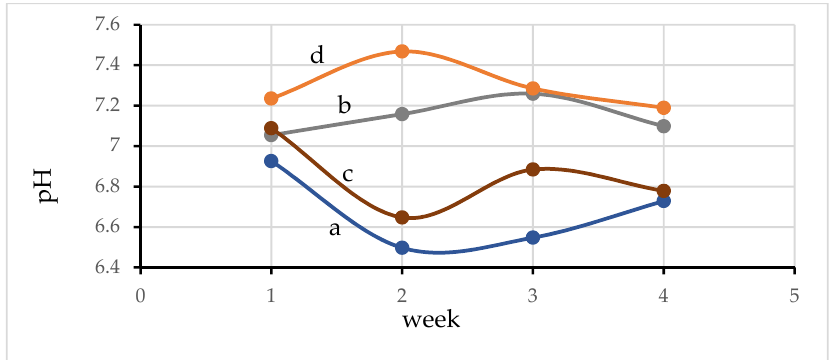
Figure 7. pH values of water of ( a ) pond 1; ( b ) the hydroponic system without an aquaculture pond; ( c ) pond 2; ( d ) and pond 3.